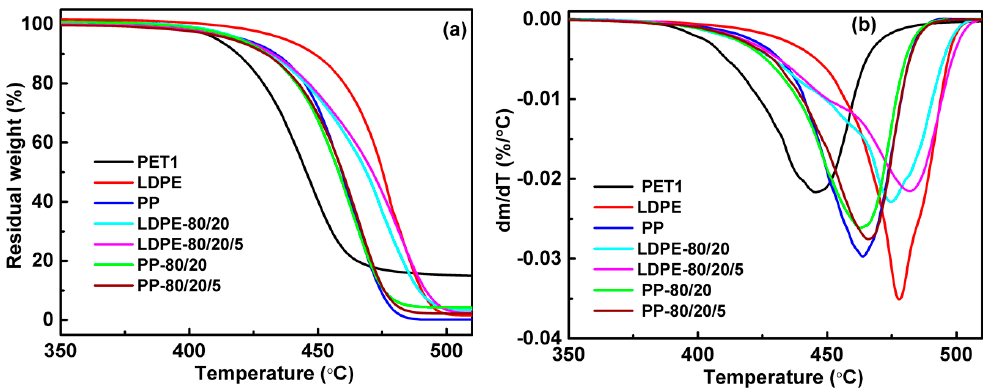
Figure 2. Comparison of TG ( a ) and DTG ( b ) curves of polymers and polymer blends.